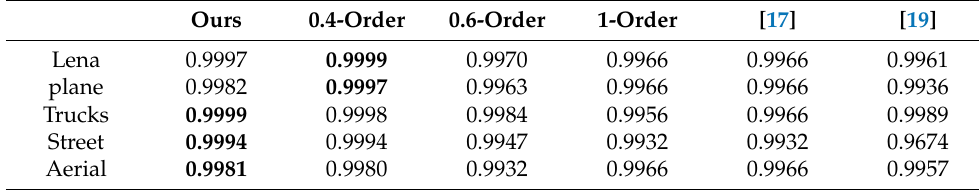
Table 4. Under different algorithms, the homogeneity values of different